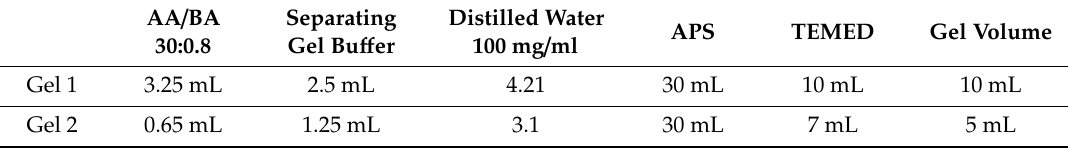
Table 1. Composition of the stacking (2) and separating (1)